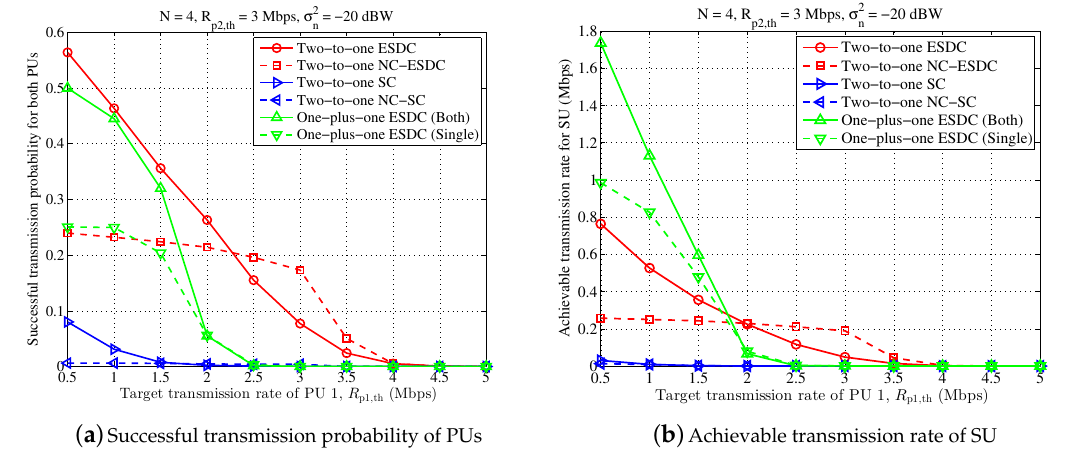
Figure 6. Performance comparison for different target transmission rates of primary user (PU) 1, in which n = 4, R p2,th = 3 Mbps, σ 2 n = − 20 dBW.